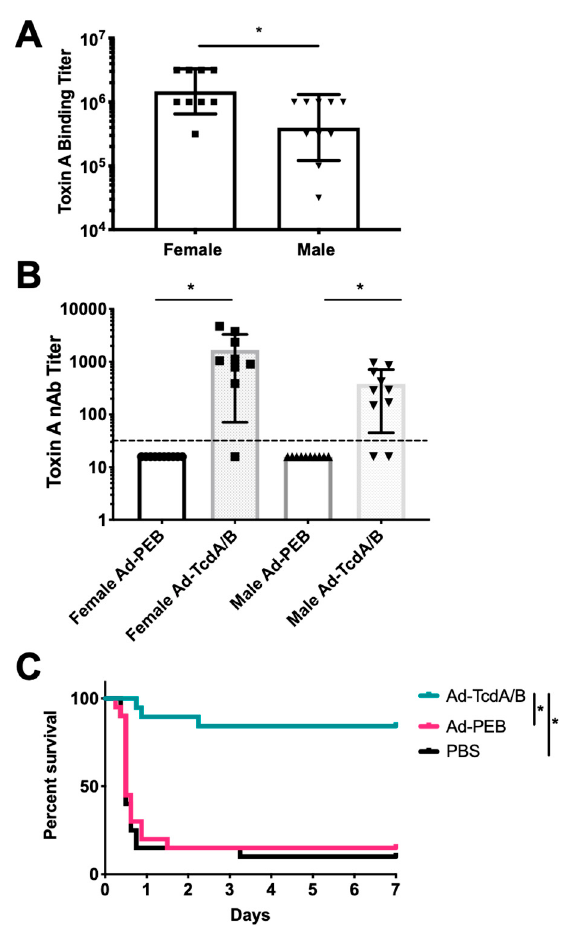
Figure 1. Serum antibody responses in immunized CD-1 mice and toxin A challenge. Male and female CD-1 mice (n = 10, per group) were vaccinated intramuscular (i.m.) with 1 × 10 10 virus particles of SC-Ad6-PEB1, SC-Ad6-TcdA / B, or phosphate-bu ff ered saline (PBS). Serum collected at week 6 was assayed by ELISA and neutralization assay. ( A ) Serum endpoint titers were determined at week 6 for male and female mice. Columns show geometric mean; bars show standard deviation; (* p < 0.01). ( B ) Neutralizing titers for Toxin A. Columns show mean; bars show standard deviation; dotted line indicates the limit of detection; (* p < 0.05). ( C ) Combined male and female survival curve following Toxin A challenge at week 8 after single immunization (* p <